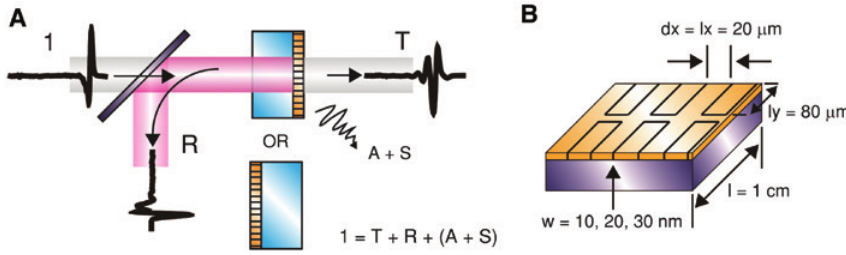
Figure 1: Experimental schematics. (A) Transmission and reflection from nanogaps, in substrate-side or air-side incidence. A silicon beam splitter is used for normal incidence reflection measurements. (B) Geometric parameters of the rectangular ring nanogaps used in the